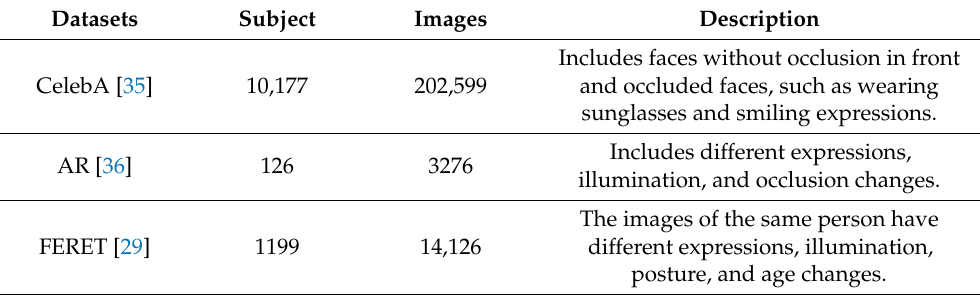
Table 2. Detailed comparison of datasets.